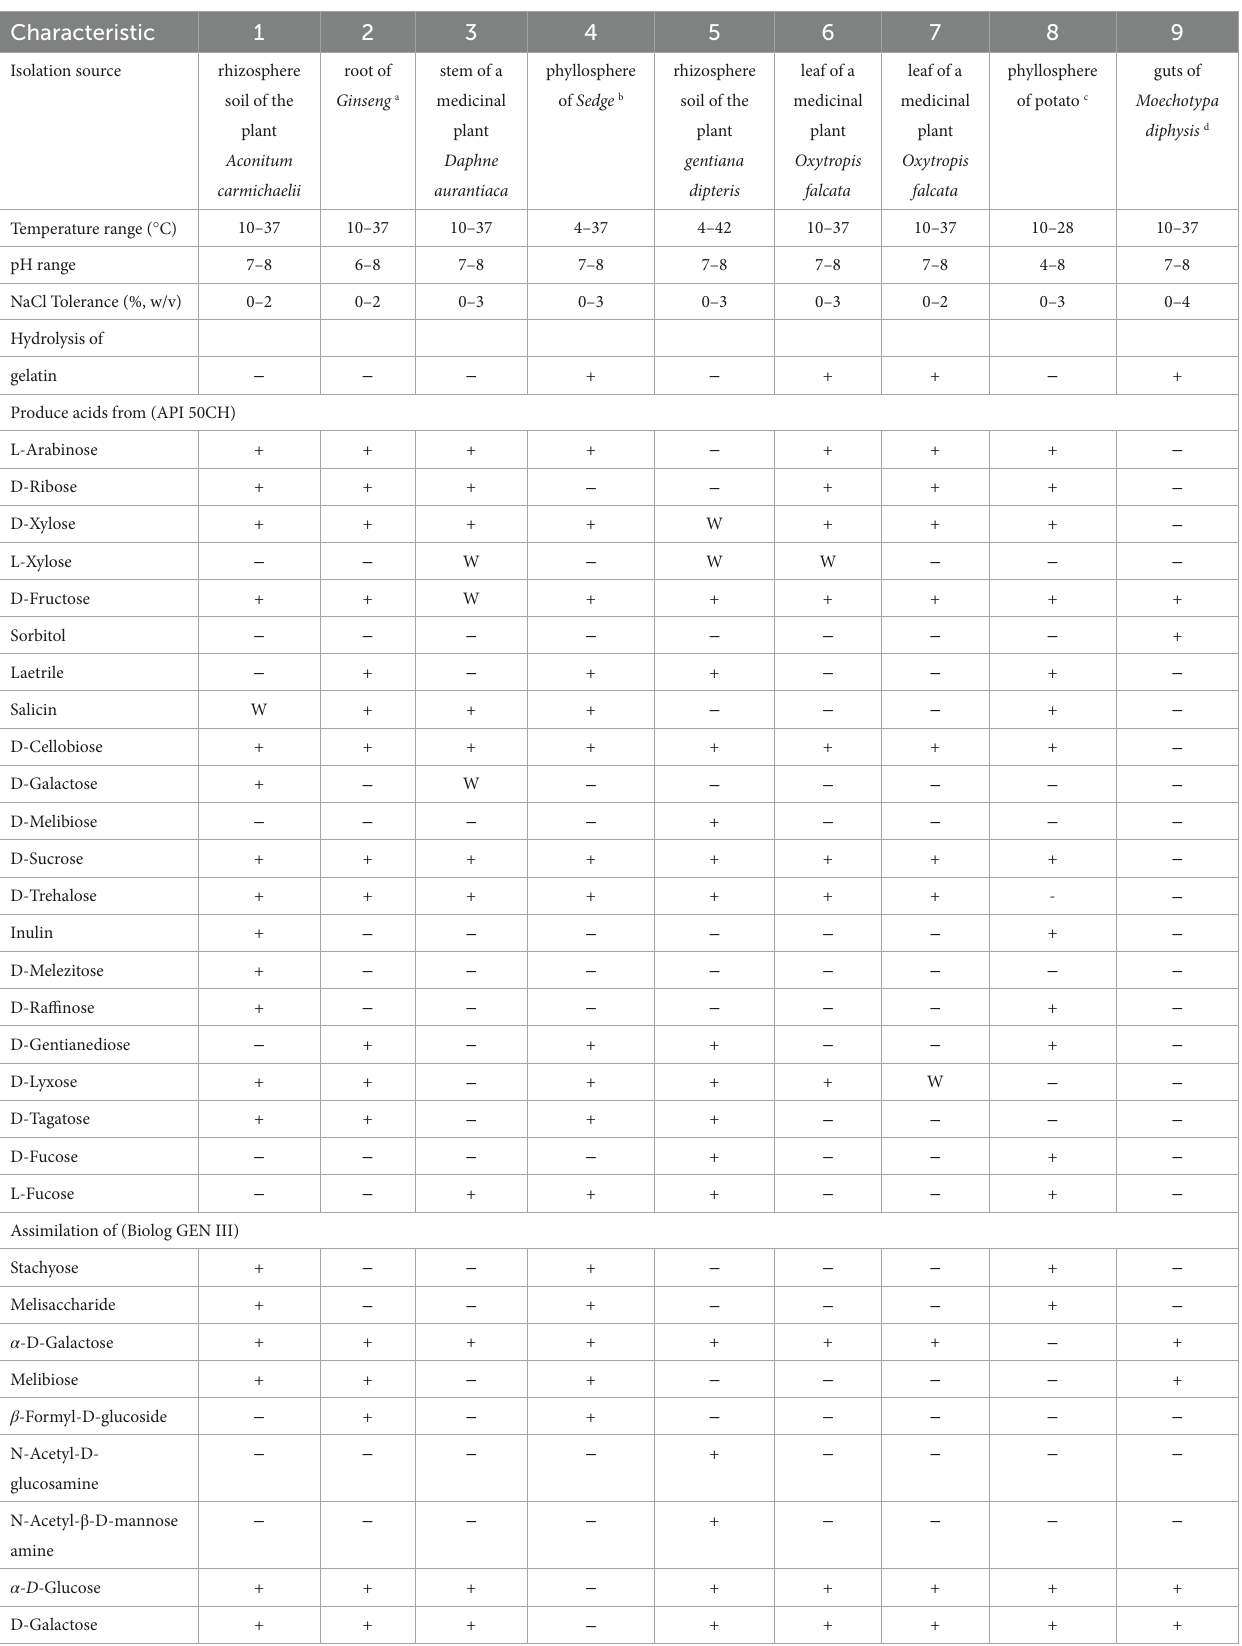
TABLE 1 Differential characteristics between strains CPCC 205763 T , CPCC 203386 T , CPCC 205716 T , CPCC 203406 T , CPCC 203407 and the closely related type strains of the genus Herbiconiux . Characteristic